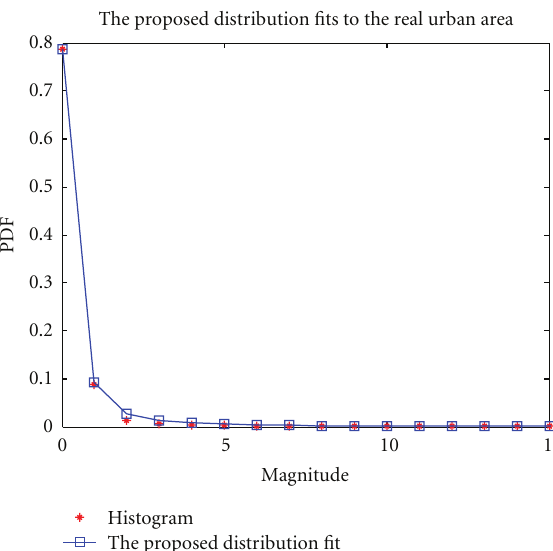
Figure 6: Plots of fitting results by limiting 𝜓 = 0 × range); see Figure 3. The three-dimension histogram of the urban interferogram is shown in Figure